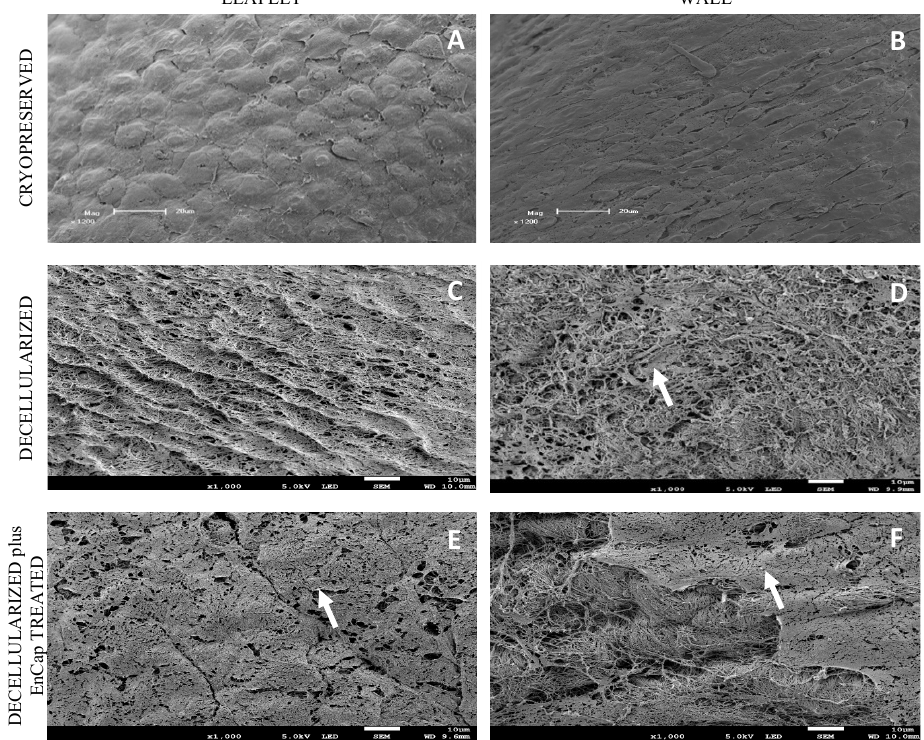
Figure 6. Representative scanning electron microscopy images of cryopreserved, decellularized, and decellularized and EnCap TM ‐ treated wall tissue processed after 48 h ischemia; white arrows point to basal membrane remnants (( A , B ) = 1200× magnification, scale bar 20 μ m; and ( C – F ) = 1000× mag ‐ nification, scale bar 10 μ m). TEM demonstrated the presence of cells and cellular remnants in the cryopreserved group (Figure 7A,B), and no interstitial cells were present in the leaflets and wall tissue in the decellularized group (Figure 7C,D) or decellularized plus EnCap TM ‐ treated group (Fig ‐ ure 7E,F). Collagen bundles appeared more loosely arranged in the decellularized group (Figure 7C,D) and more compressed and dense in the decellularized plus EnCap TM ‐ treated group (Figure 7E,F).